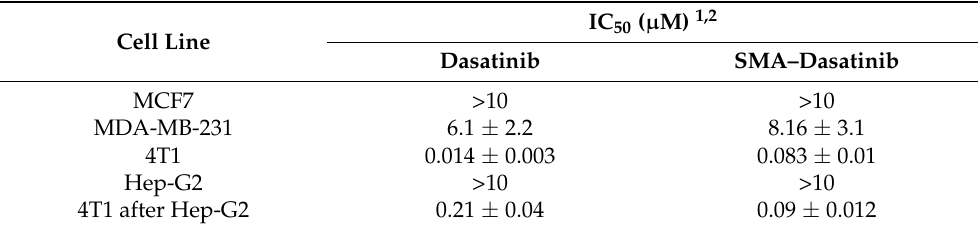
Table 2. Experimental IC 50 values ( µ M) of free dasatinib and SMA–dasatinib towards human MDA- MB-231, 4T1, and MCF-7 cells.